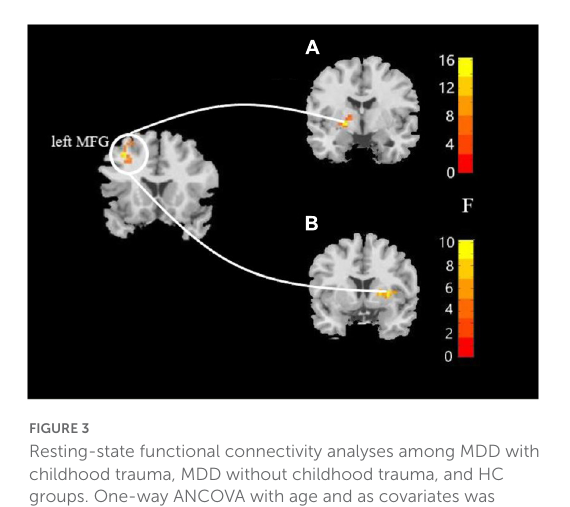
FIGURE3 Resting-state functional connectivity analyses among MDD with childhood trauma, MDD without childhood trauma, and HC groups. One-way ANCOVA with age and as covariates was performed to compare functional connectivity maps in all the three groups and identified significant differences between left middle frontal gyrus and bilateral putamen ( A , left putamen gyrus; B , right putamen gyrus) (AlphaSim-corrected p < 0.05).